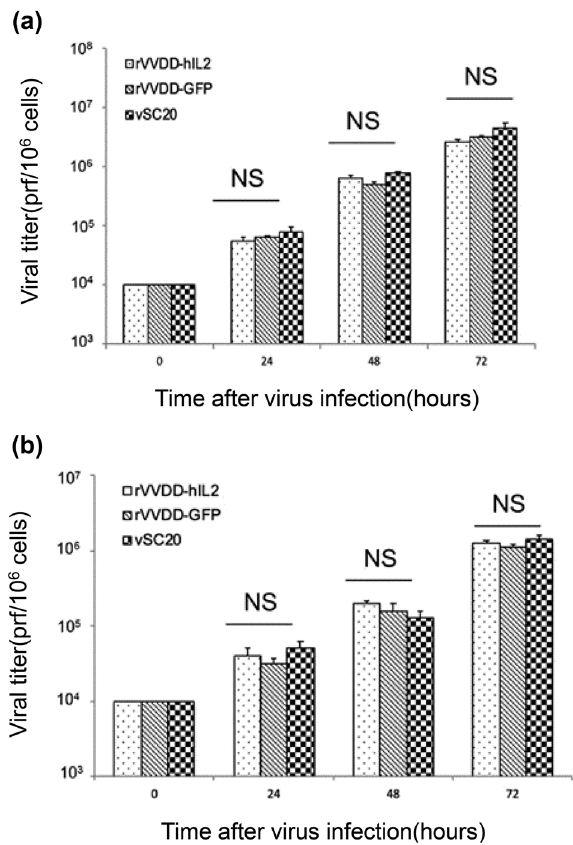
Figure 4: Replication e ffi ciency of rVVDD - hIL2 in tumor cell lines. ( a ) Viral titers in a human tumor cell line. A549 ells were infected with vSC20 or its derivatives rVVDD - hIL2 and rVVDD - GFP, at an MOI of 0.01 and harvested at the indicated times post - infection. Viral titers were determined in CV - 1 cells. ( b ) Viral titers in a mouse tumor cell line. MC38 cells were infected with the same viruses as A549 cells, and viral titers were also tested in CV - 1 cells. NS, non - signi fi cant ( P > 0.05 ) . All comparisons were analyzed by one - way analysis of